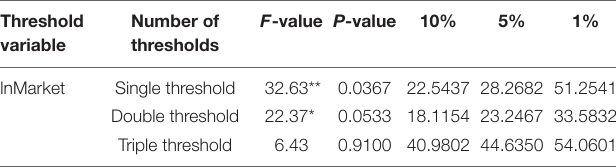
TABLE 6 | Panel threshold test results.